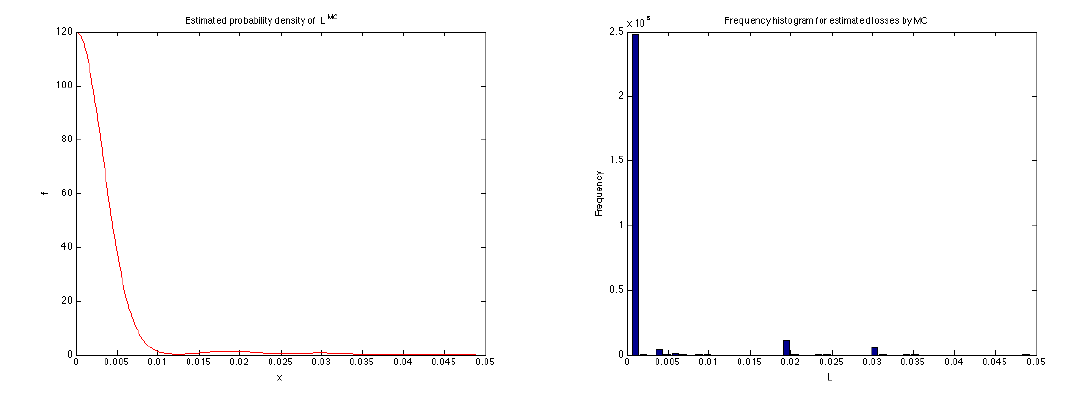
Figure 9: Estimated PDF of Loss from the MC simulated data represented in the adjacent frequency